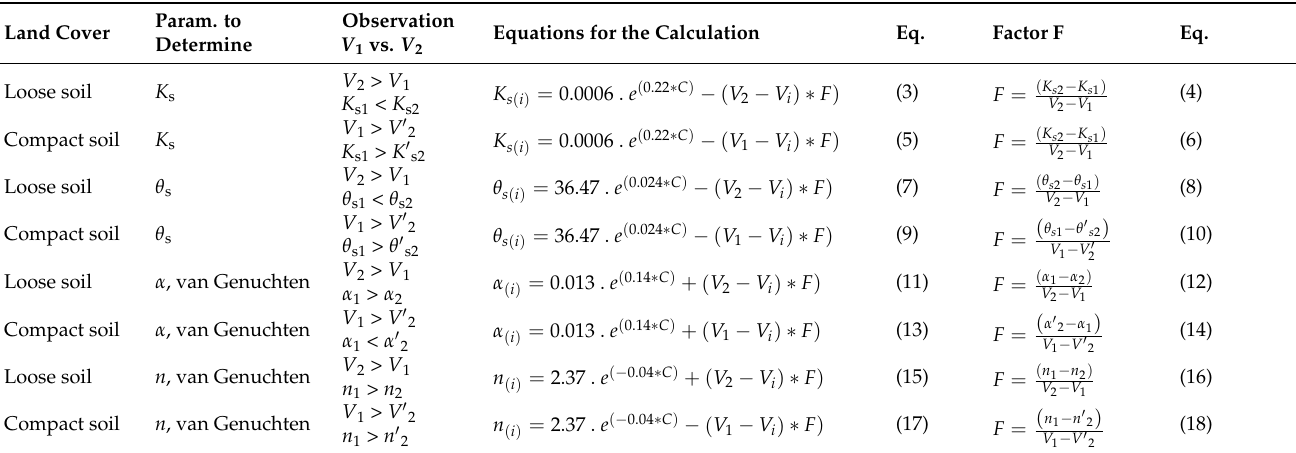
Table 2. Equations for the prediction of soil parameters K s , θ s and van Genuchten parameters α and n with m = 1–1/ n (calibration at 20 min).